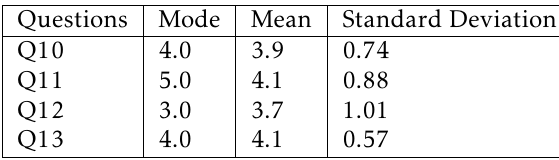
Table 4. Statistics obtained from the participants answers related to the overall evaluation of the